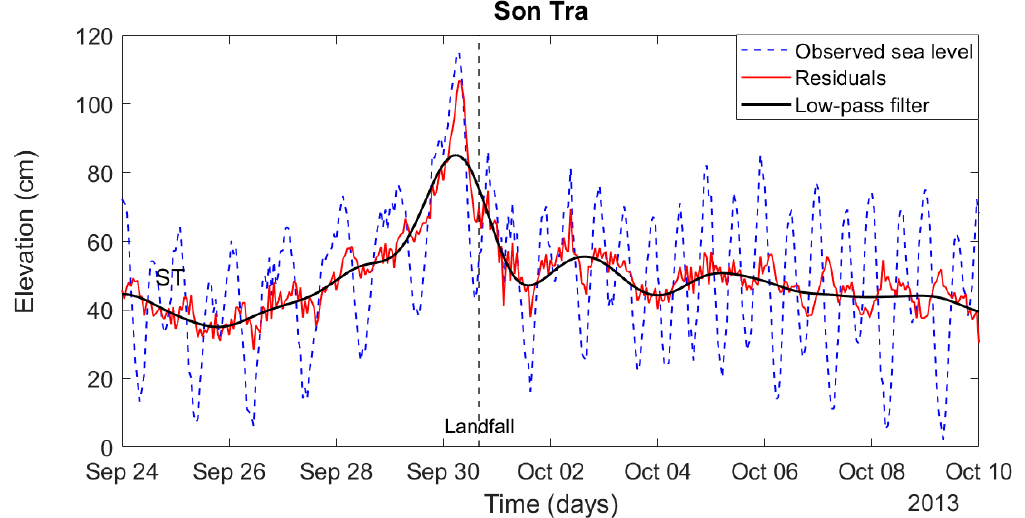
Figure 8. Time series of observed, residual and low-pass filtered water levels during Typhoon Wutip (24 September to 9 October 2013) at Son Tra tide gauge.